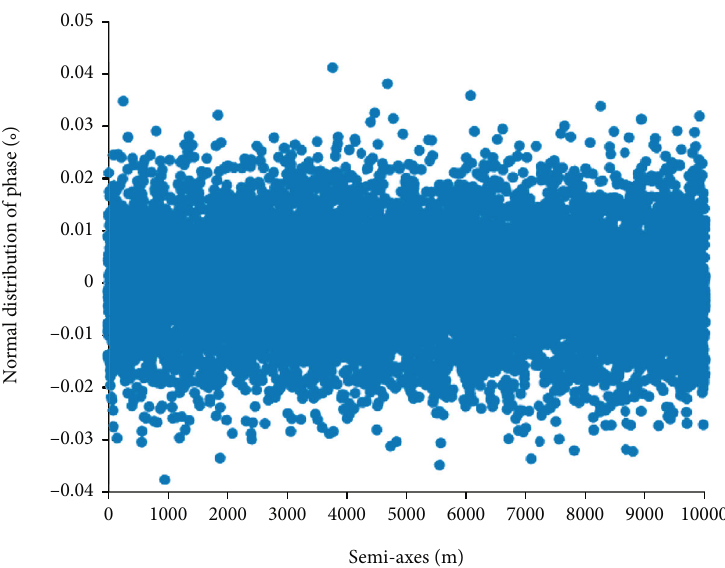
Figure 7: Normal distribution of track